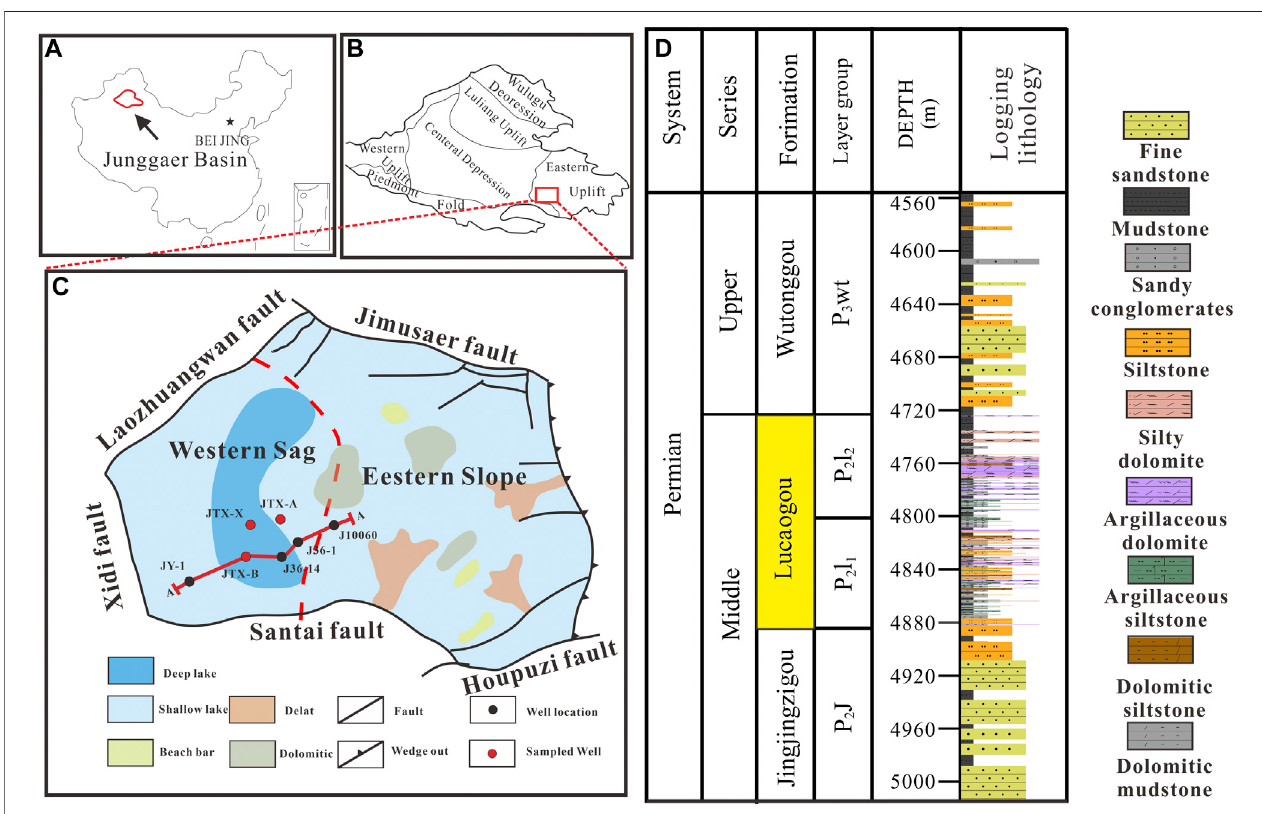
FIGURE 1 | (A) Location of Junggar basin; (B) Location of Jimusar depression; (C) Typical stratigraphic column of Jimusar depression; and (D) The general lithologic stratigraphy of Jimusar sag.